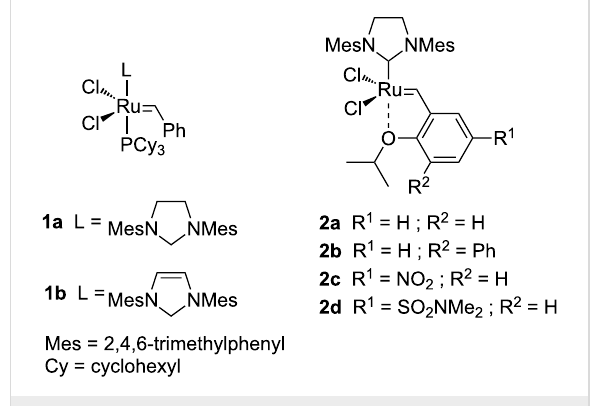
Figure 1: Ruthenium precatalysts for olefin metathesis.